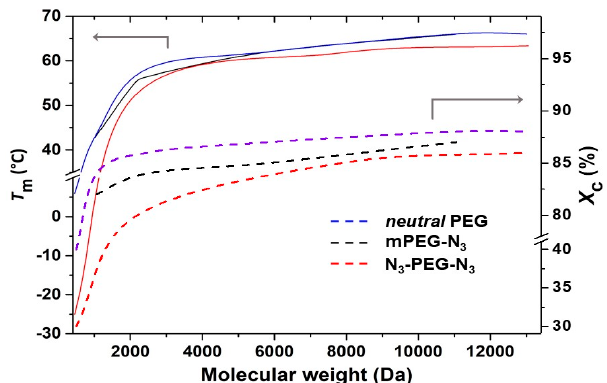
Figure 5. Dependence of T m and X c on the molecular weight of neutral PEG, mPEG-N 3 and N 3 -PEG-N 3 series.